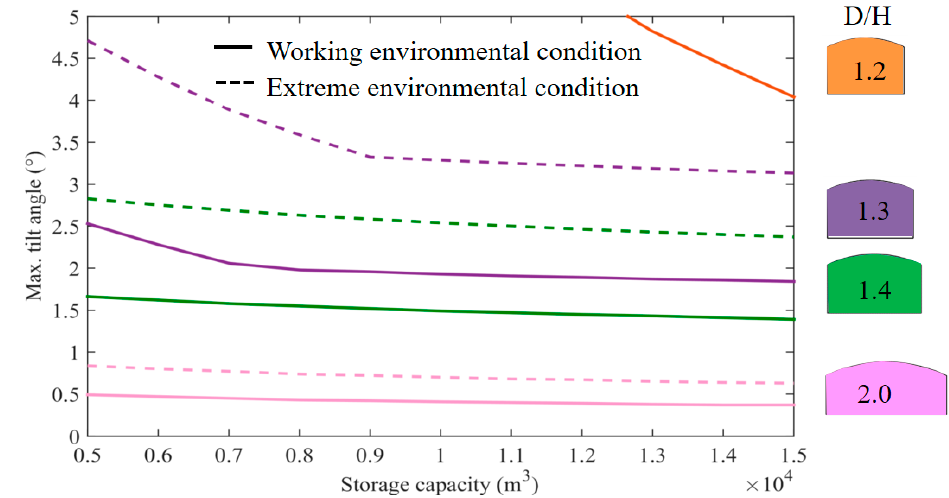
Figure 16. Maximum tilting angle of double-hull storage tanks (L/D = 1.05).